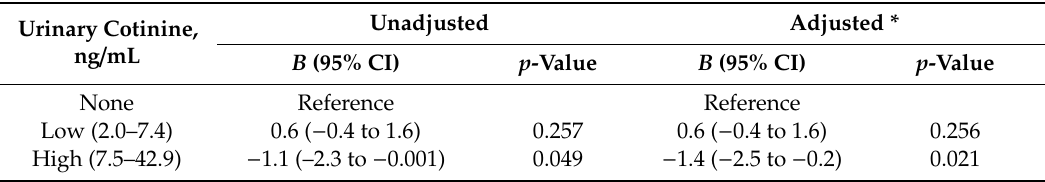
Table 4. Multivariable linear regression analysis for the association between urinary cotinine level of maternal subject and newborn’s length. Urinary